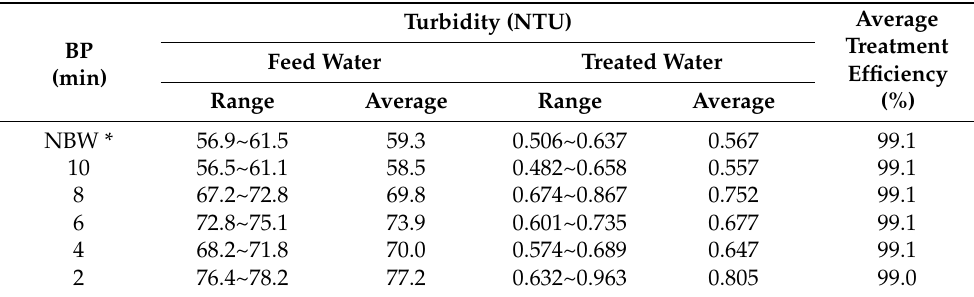
Table 9. Water quality and treatment efficiency of turbidity in the combined process of seven channel alumina MF (HC04) and PP beads for the influence of water backwashing